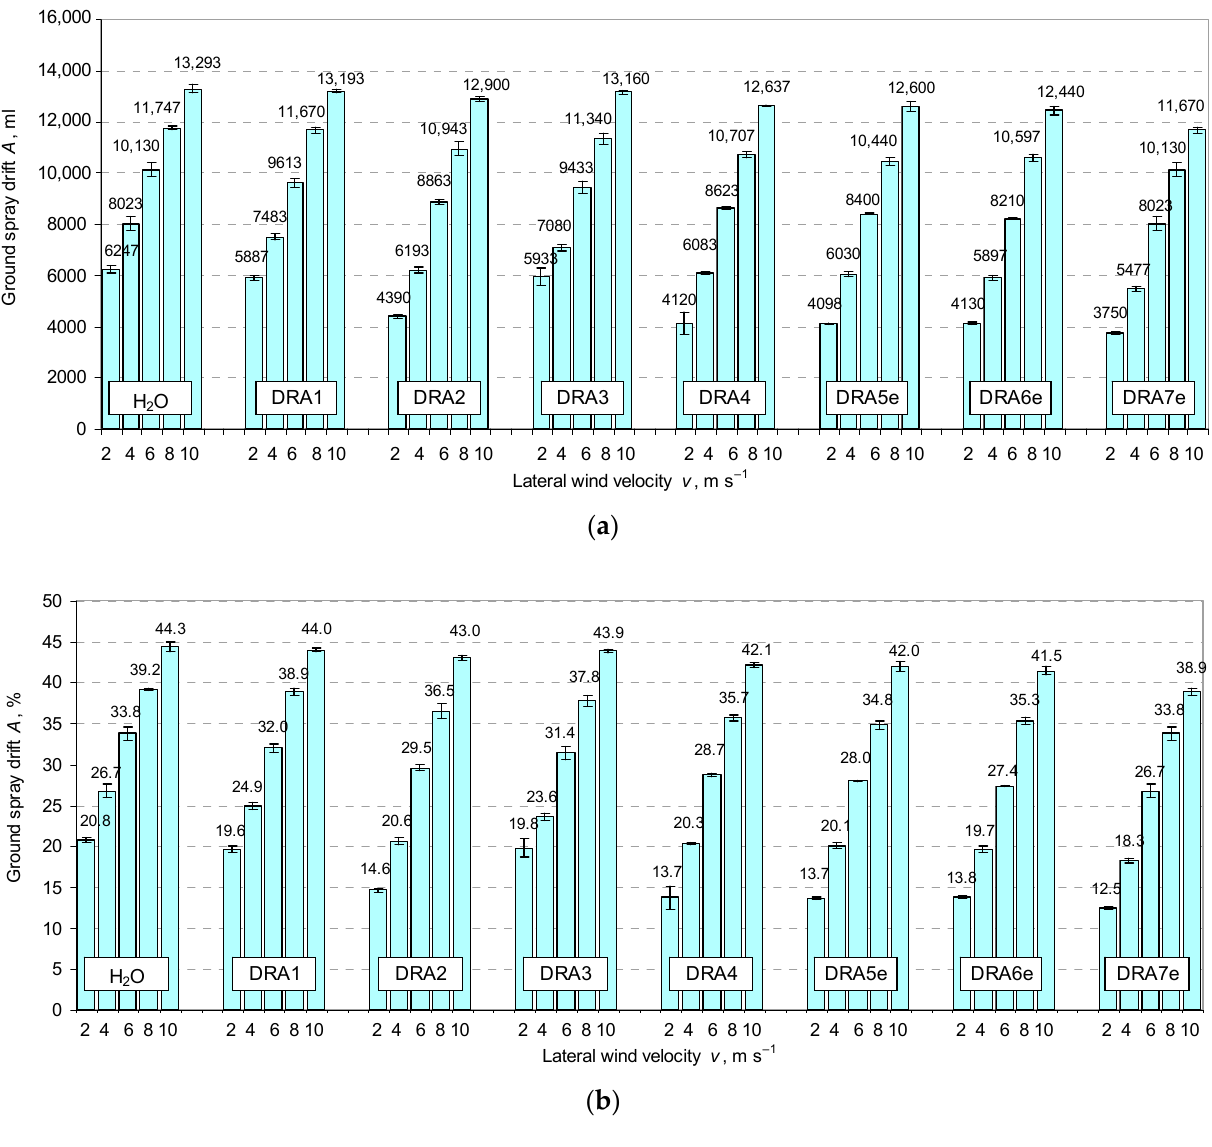
Figure 7. Droplet ground spray drift as a function of lateral air velocity and solution type when sprayed with standard flat spray nozzles in a wind tunnel: ( a ) ml; ( b ) %. According to the experimental results, air velocity, solution, and nozzles have a ma- jor influence on ground spray drift. When comparing the air-injector flat spray nozzles with standard flat spray nozzles, there is a significant drift of the sprayed liquid: about two times higher with the standard flat spray nozzles (Figure 8). This result was not sur- prising as air-injector flat spray nozzles are known to generate larger droplets than stand- ard flat spray nozzles. Larger droplets are less susceptible to winds due to their greater mass. Griesang et al. [47] suggested that nozzle patterns influence droplet size character- istics and drift. Therefore, in some cases, the greater the reduction in drift, the more it is influenced by the nozzles rather than by the solution used. Itmeç et al. [56] found that increasing the spray pressure from 3 bar to 5 bar increases the droplet drift of sprayed solutions. Hofman and Solseng [32] state that the selection of suitable nozzles depending on the pesticide to be sprayed is particularly important. Our experimental studies demon- strated that for both nozzles studied, the lowest droplet drift was obtained when spraying the newly developed solution DRA7e, compared to two other newly developed solutions, four commercial solutions, and the control. The lowest droplet drift was found for solu- tion DRA4 when comparing the commercial solutions with each other and with the